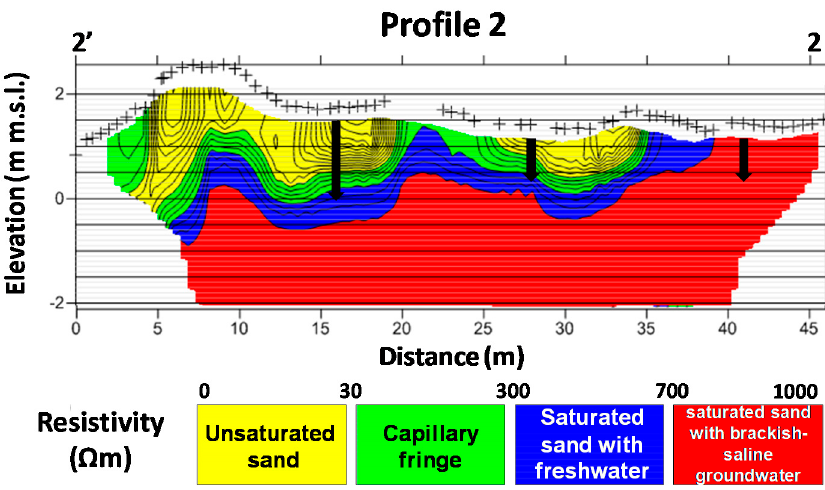
Figure 6. Subsurface model of profile 2’-2. Black arrows represent the auger holes location and the arrow head the measured WTD.